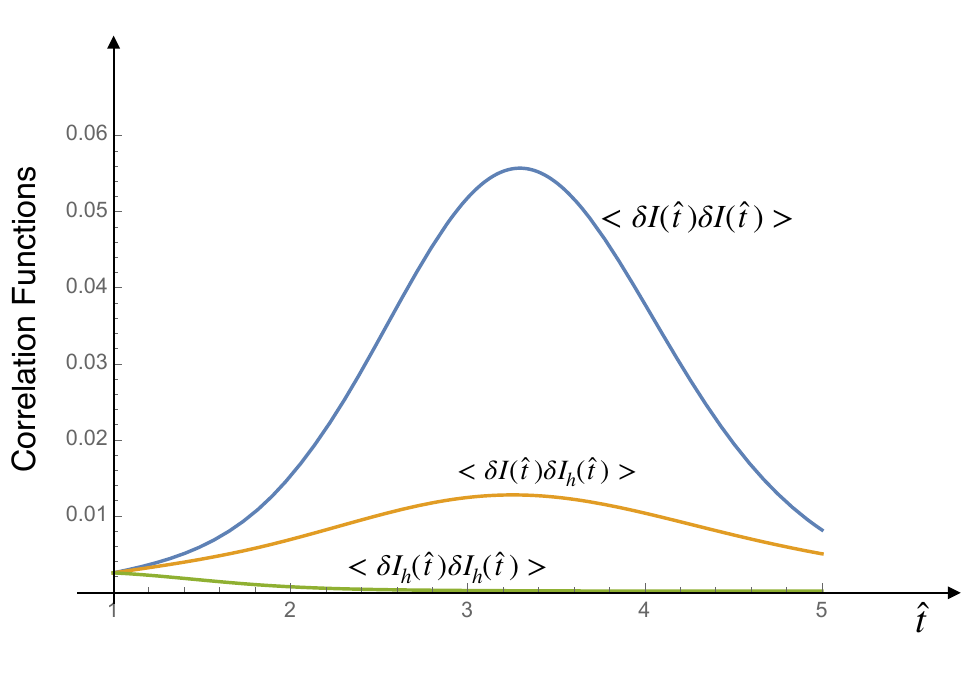
Figure 19. Correlation functions < δ I ( t ) δ I ( t ) > , < δ I h ( t ) δ I h ( t ) > , and < δ I ( t ) δ I h ( t ) > . These three correlation functions are obtained by solving numerically system